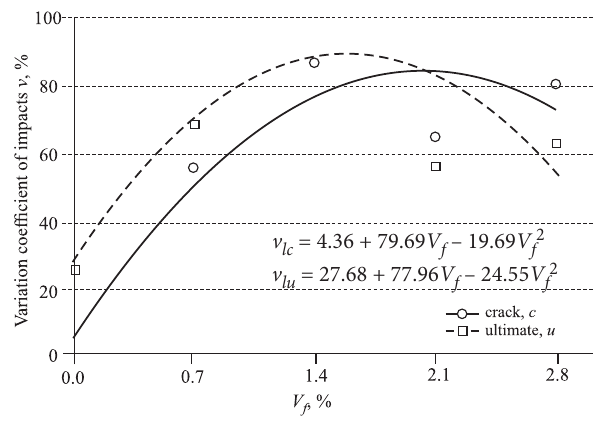
Fig. 7. Variation coefficient of impact